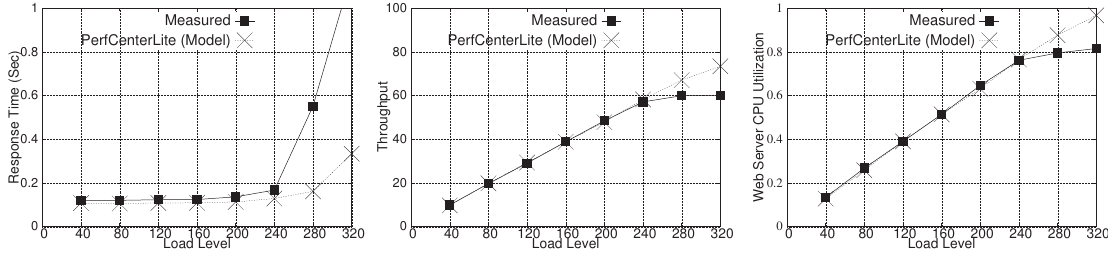
Figure 3: Measured vs Modeled Performance Metrics Validation for increased number of cores and higher frequency (Experi- ment 1)